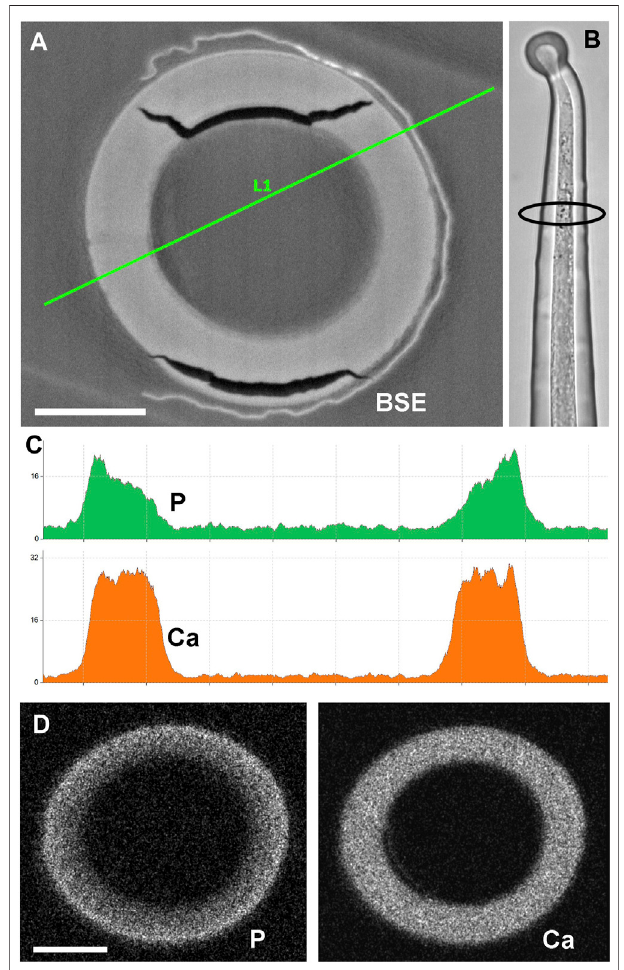
FIGURE 7 | Cross section of embedded stinging hair of Loasa pallida andanalysisofPandCadistribution. (A) BSEimagewithEDXlinescan (C) ;the LM image (B) illustrates the position of the section close to the apex. The line- scan concentrationpro fi les and element mappingimages (D) acrossthe cell walls show a continuous decrease in P concentration from outside to inside, contrasting with a constant Ca concentration across the wall. Scale bars: 10